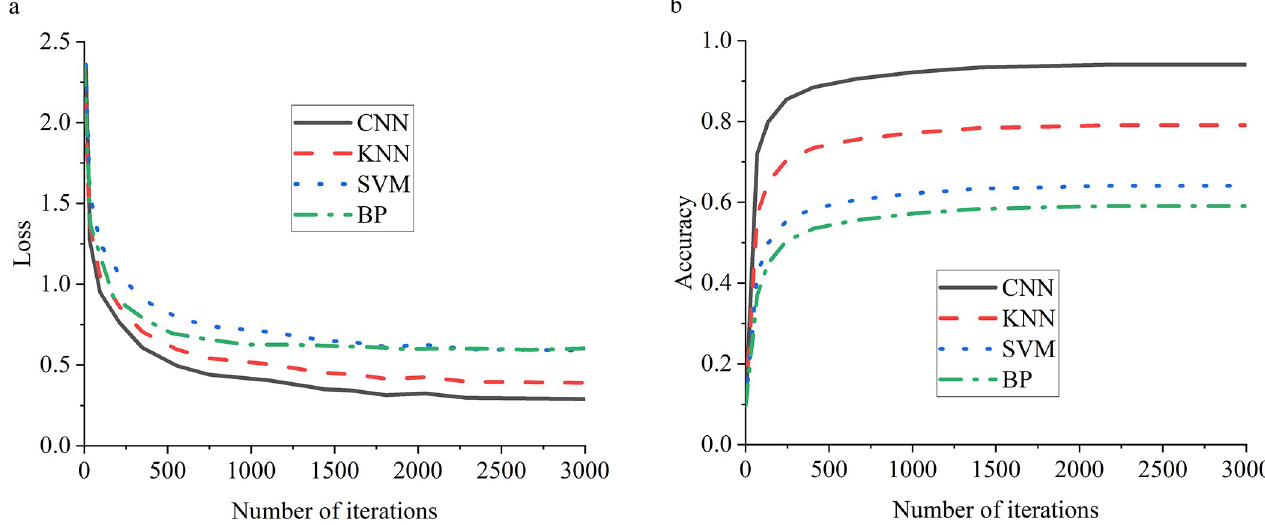
Fig 5. Comparison of film poster recognition performance of different models (a: learning performance, b: calculation accuracy).